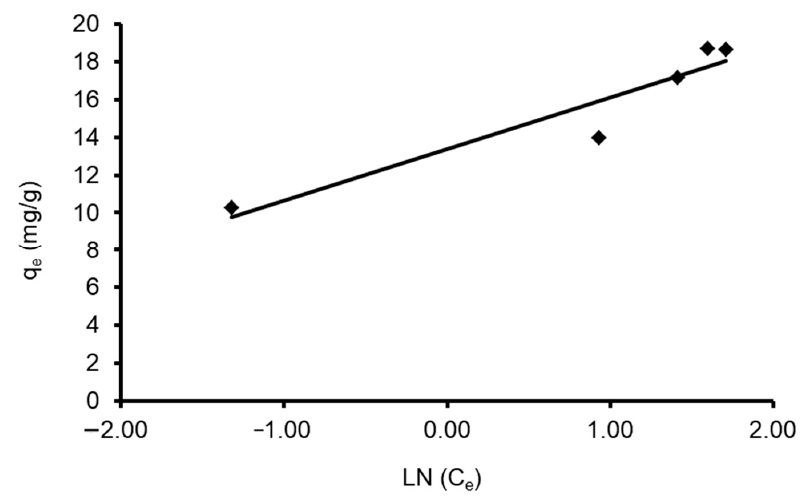
Figure 12. Plot of the Tempkin isotherm models for CVD adsorbed onto S. costatum .